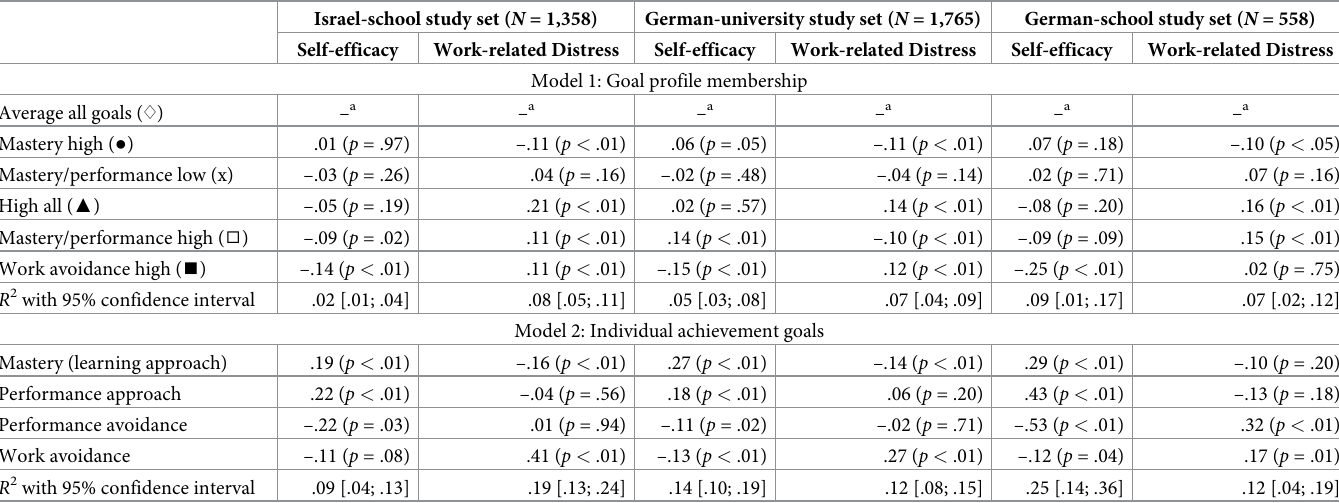
Table 4. Results of structural equation models analyzing the relations between goals profiles and individual goals with self-effiacy and work-related